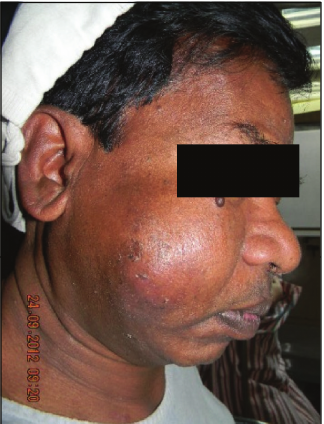
Figure 1: Clinical image showing right side of the face with a solitary mass extending from posterior ala region to preauricular area. Superiorly, it extends till infraorbital margin to angle of the mouth